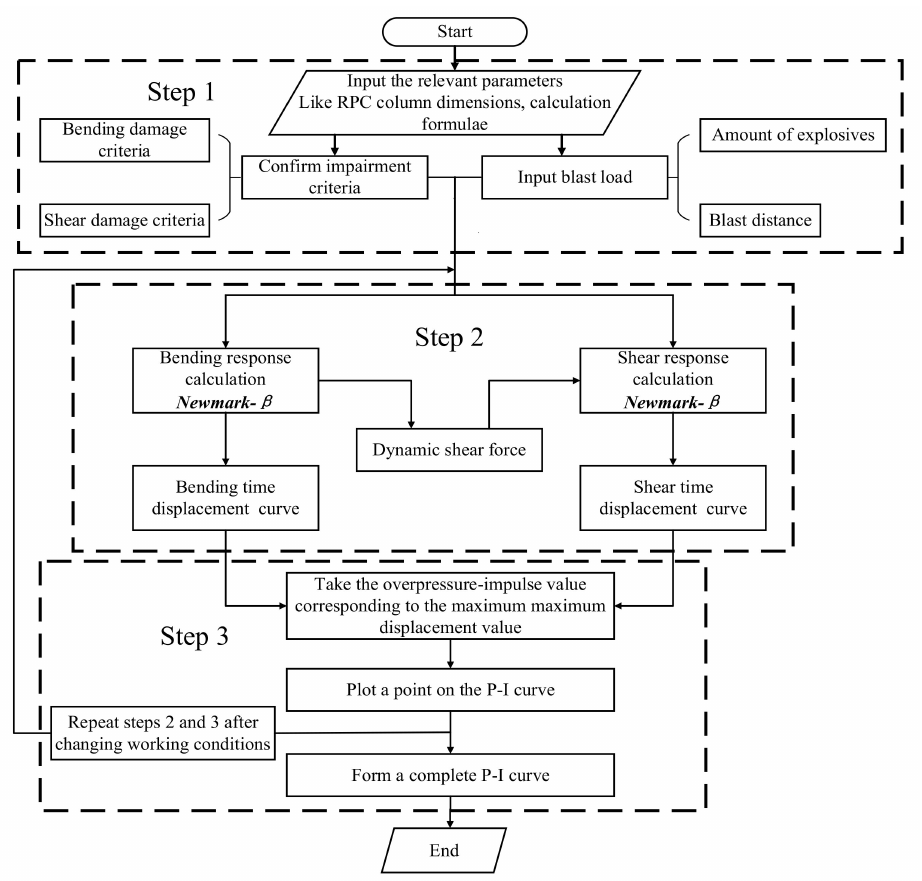
Figure 8. Flow chart for calculation of RPC columns P-I curves.